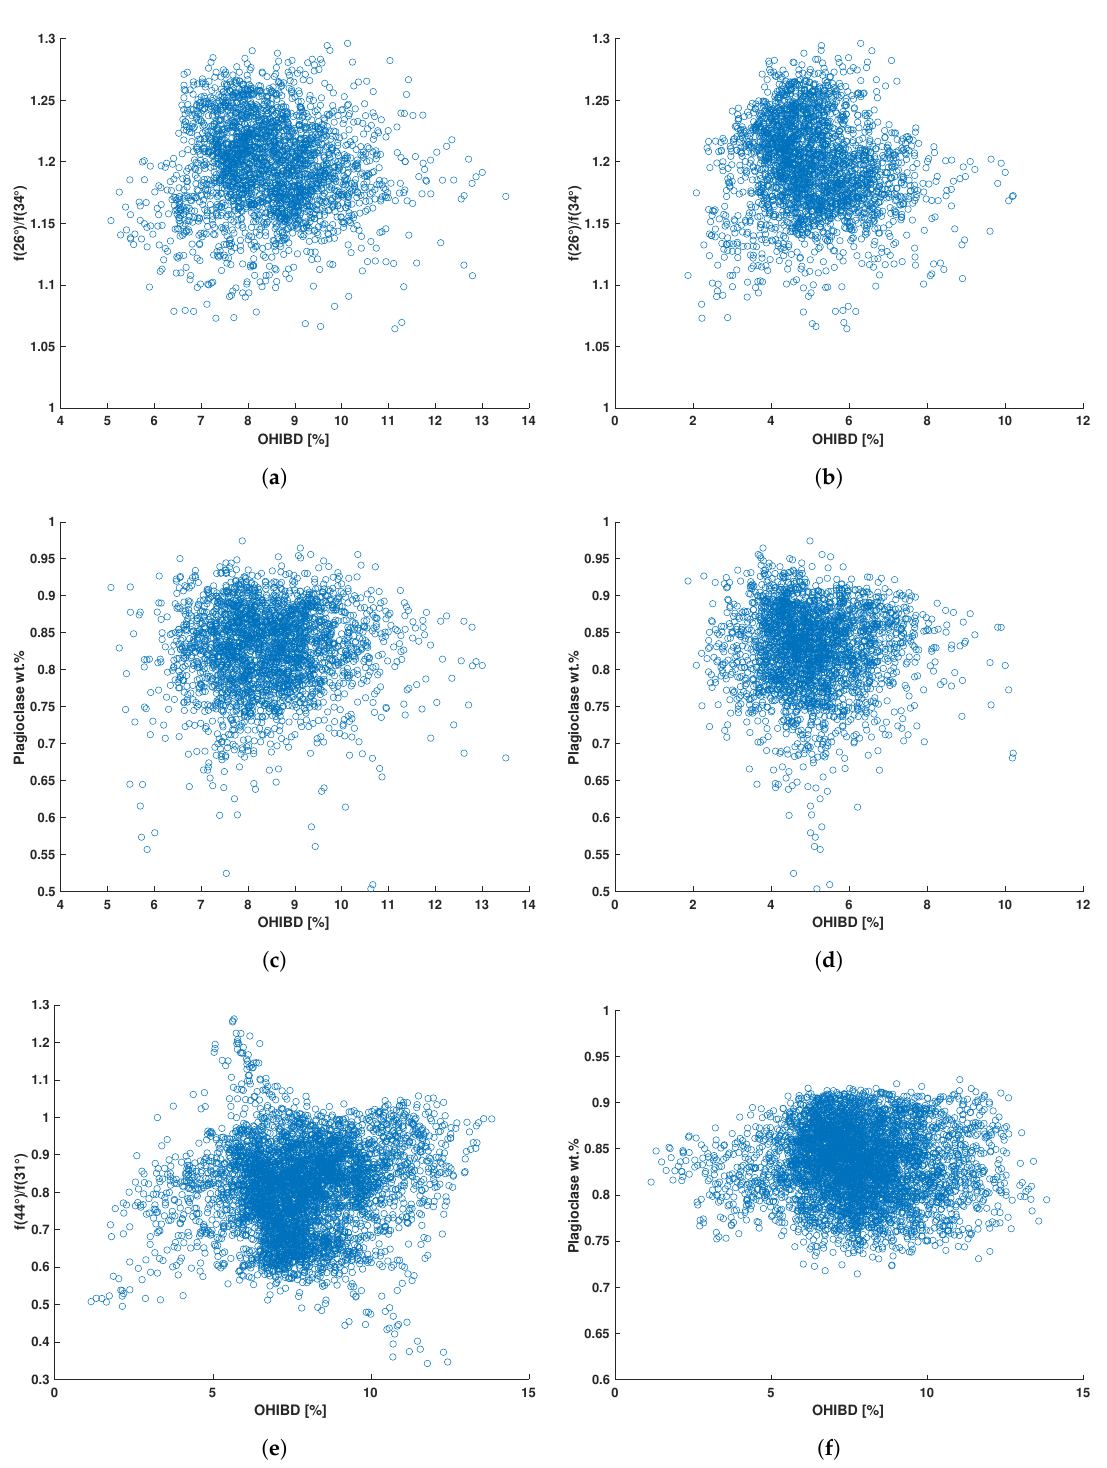
Figure A10. Correlations of plagioclase abundance and phase ratio values with the OHIBD values at Mare Moscoviense and Theophilus crater (Figures A8 and A9), for the entire region of interest re- spectively. ( a ) Mare Moscoviense morning ( r = 0.043), ( b ) Mare Moscoviense midday ( r = 0.096), ( c ) Mare Moscoviense morning ( r = 0.055), ( d ) Mare Moscoviense midday ( r = 0.019), ( e ) Theophilus ( r = 0.126), ( f ) Theophilus ( r =